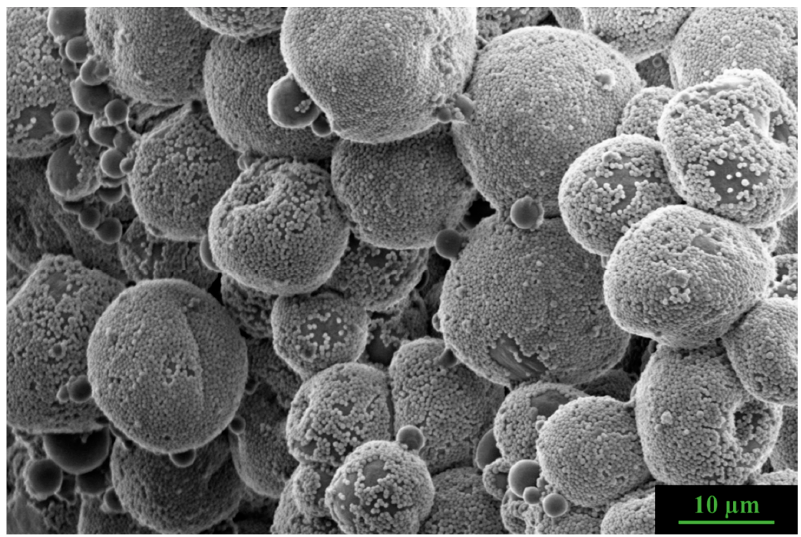
Figure 5. SEM image of the wax colloidosomes decorated with JNP-bPEI 3 mL, employed in interfacial extraction of metal ions.